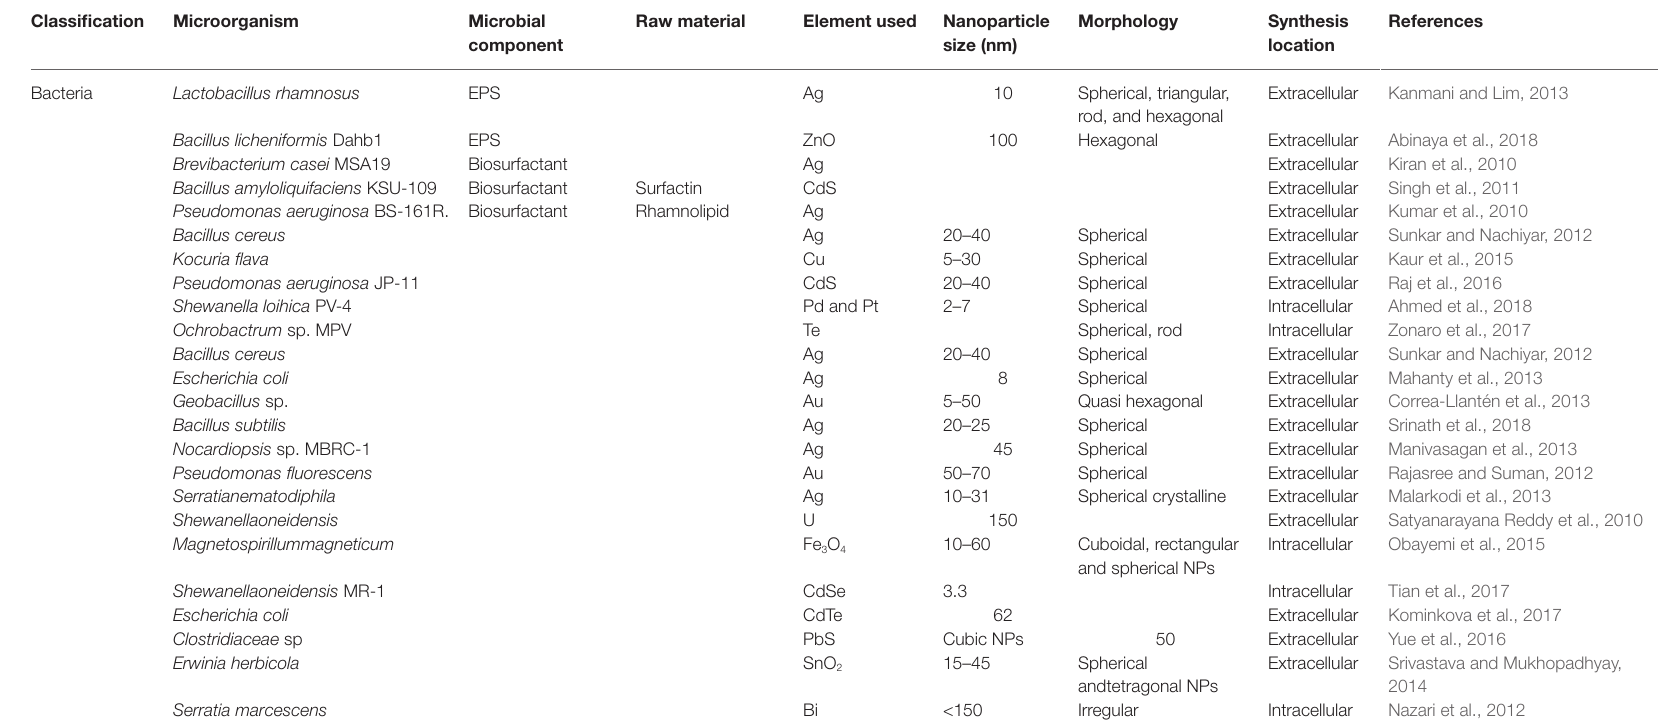
TABLE 1 | Contribution of microbes in the formation of